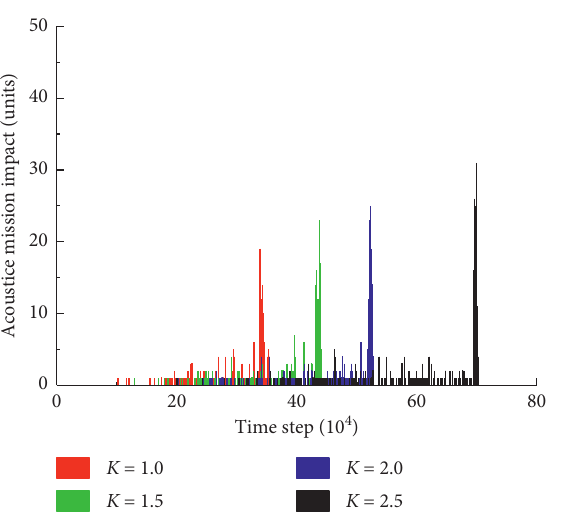
Figure 8: Acoustic emission-time step characteristic curves of rock specimens with different values of K